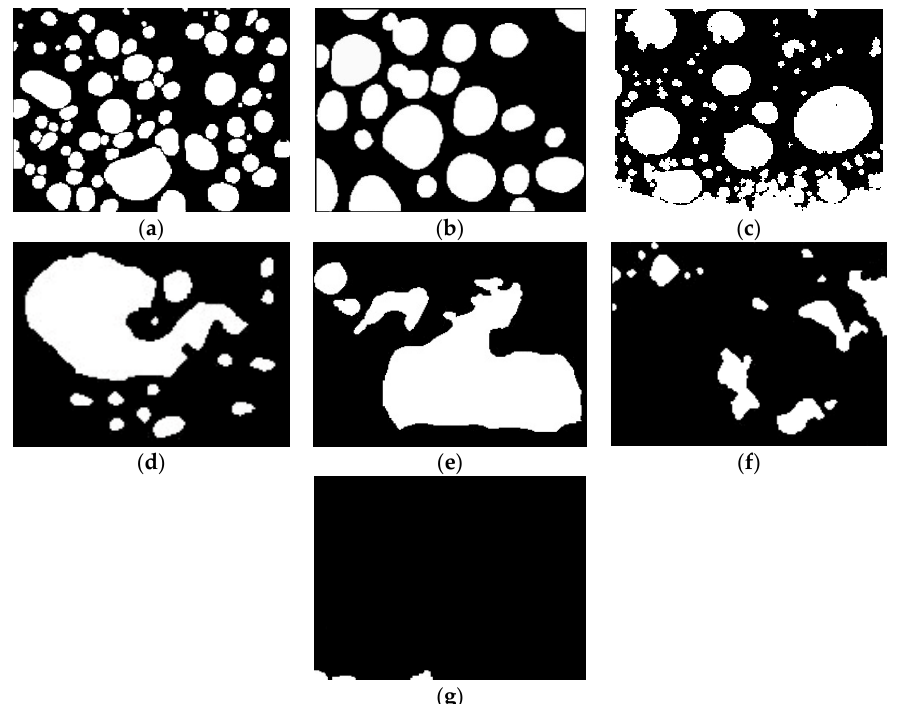
Figure 8. Hydrophobic image correction based on morphological algorithm. ( a ) HC1; ( b ) HC2; ( c ) HC3; ( d ) HC4; ( e ) HC5; ( f ) HC6; ( g ) HC7.